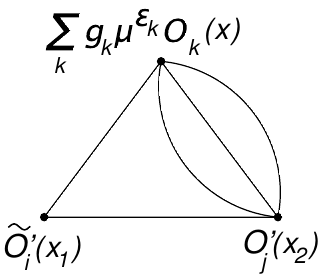
( x ) O (cid:48) ( x ) 〉 . Solid lines i 1 2 j